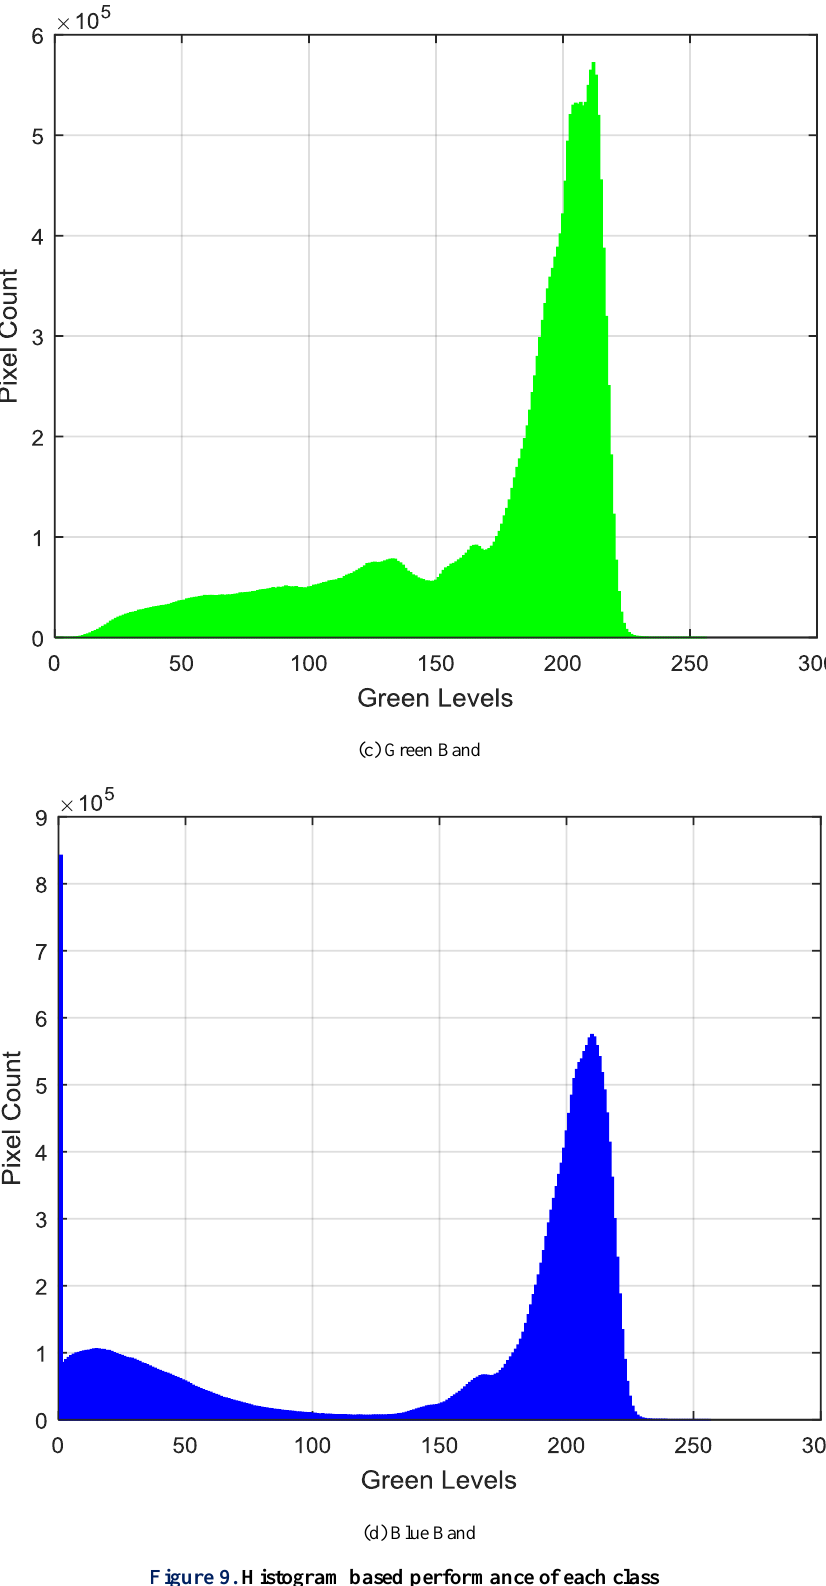
Figure 9. Histogram based performance of each